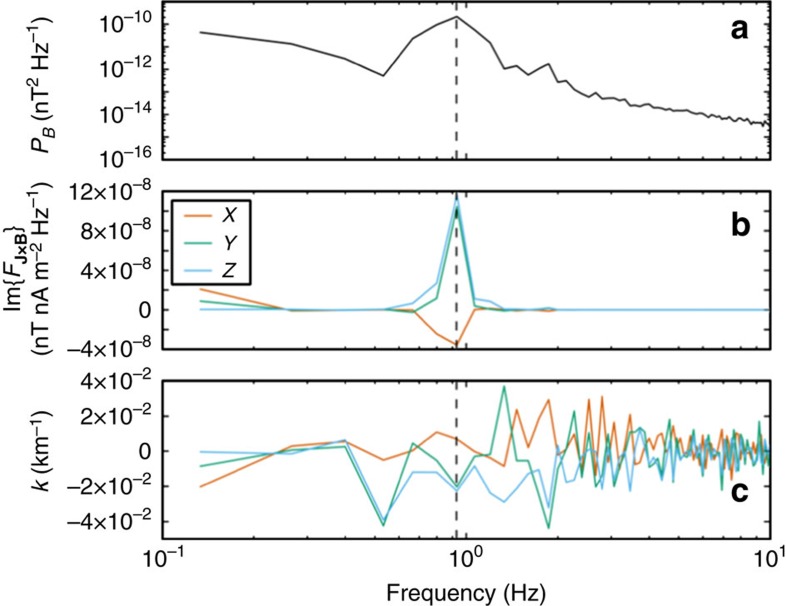
Wavevector estimated from current density fluctuations.(a) Power spectral density of MMS-averaged magnetic field magnitude from 22:26:28.18–22:26:35.83 UT, (b) the imaginary part of the Fourier amplitudes of fluctuations in MMS-averaged J × B and (c) corresponding components of k(ω) derived using the Bellan2324 technique. At the spectral peak of ∼0.9 Hz, k=[7.1 × 10−3, −2.0 × 10−2, −2.2 × 10−2] km−1. This wavevector yielded ρi∼1 and an angle of ∼100° with respect to the background magnetic field.